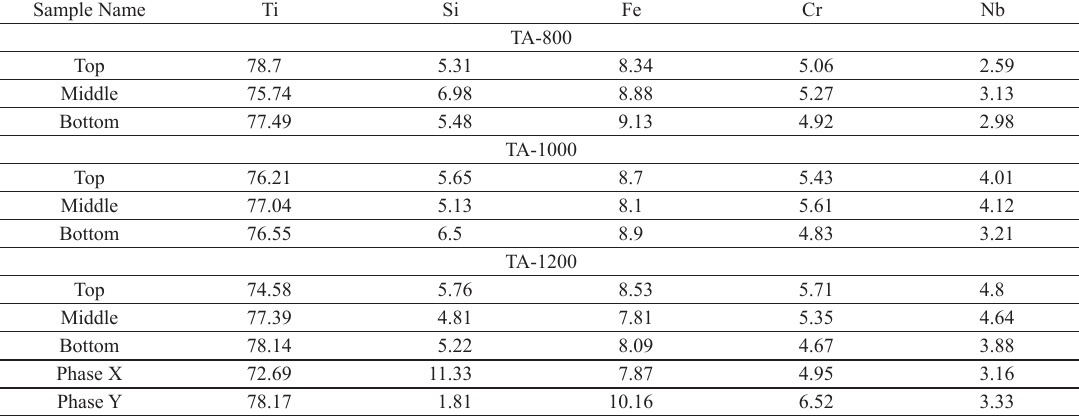
Table 2. EDS results.